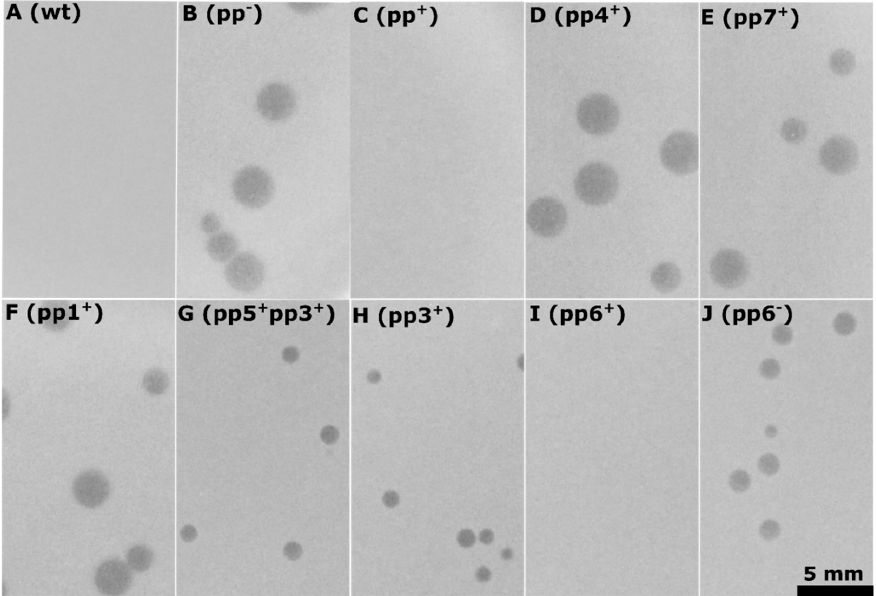
Figure 3. V583 endogenous prophages (pps) interference with Idefix infection, plaque assays performed